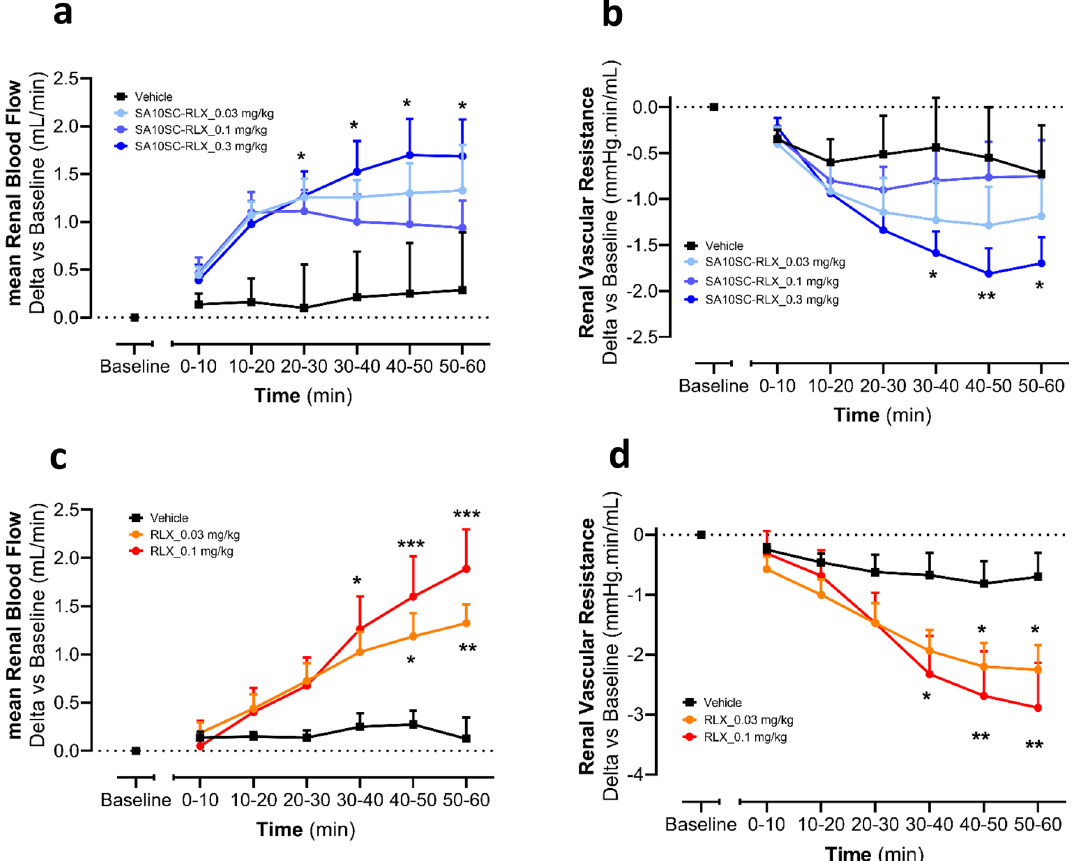
Figure 6. Effect of SA10SC-RLX and relaxin on renal blood flow and renal vascular resistance in anesthetized SD rat. Effects of IV administration of SA10SC-RLX (blue curves) or relaxin (orange and red curves) on mean Renal Blood Flow (RBF) ( a, c ) and renal vascular resistance (RVR) ( b , d ) in anesthetized SD rats. Results are expressed as mean ± SEM of changes from baseline for each animal (n = 8/group). A two-way analysis of variance was performed on rank-transformed data for both mean RBF and RVR, followed by two-tailed Dunnett’s test, versus vehicle for group factor (* P < 0.05; ** P < 0.01; *** P <